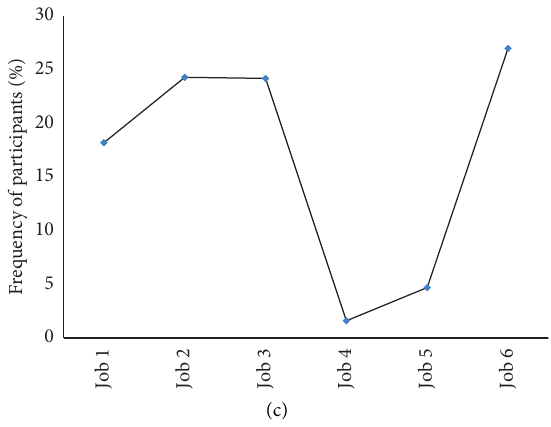
Figure 5: Descriptive statistics related to Table 5: The results of exploratory factor analysis.